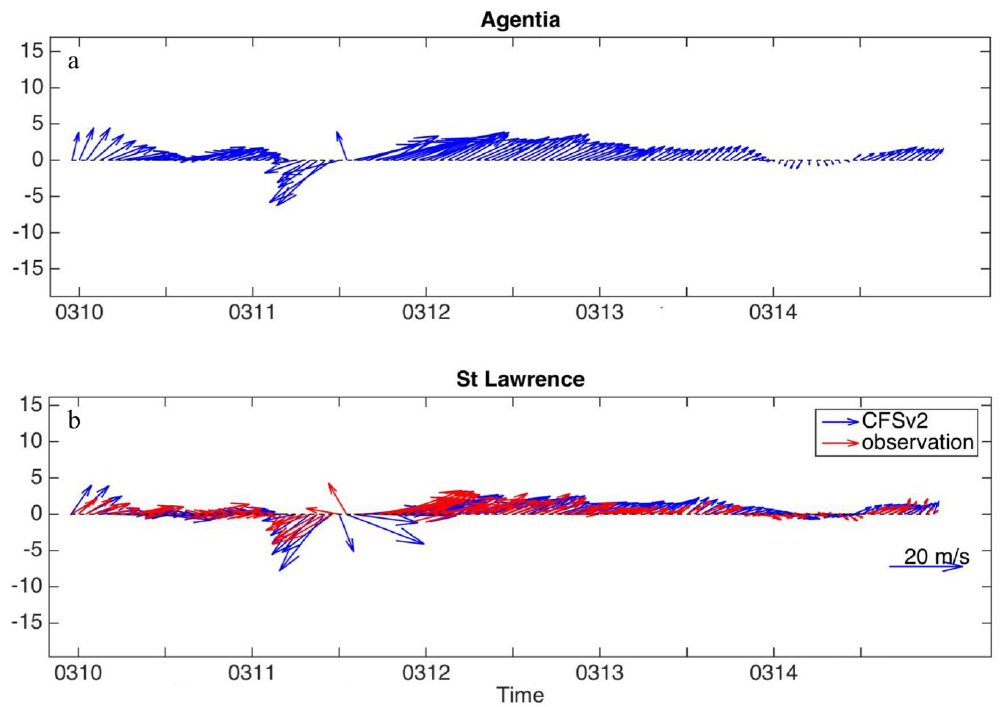
Figure 12. Hourly wind vectors (m s −1 ) from CFSv2 (blue) and weather station observations (red) at AG ( a ) and SL ( b ) from March 10 to 14, 2017.